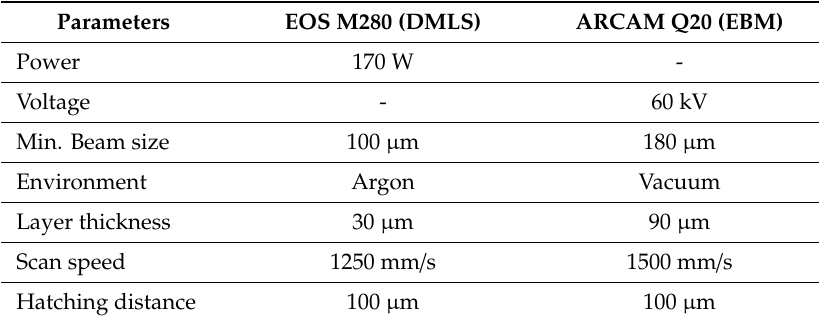
Table 1. Parameters used in the direct metal laser sintering (DMLS) and electron beam melting (EBM) processes.